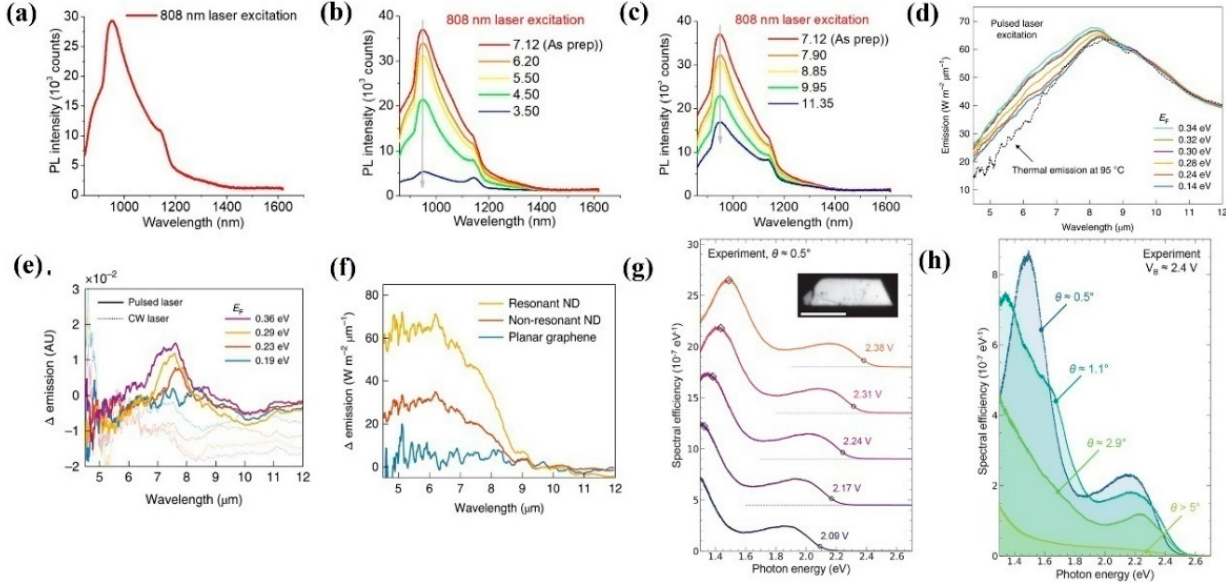
Figure 1. Light emission and devices based on graphene. ( a ) NIR emission of RGQD under 808 nm lased illumination. ( b , c ) Fluorescence spectra of RGQDs under different PH values and 808 nm lased illumination. ( d ) The Fermi − Level − dependent emission spectra of graphene. ( e ) The